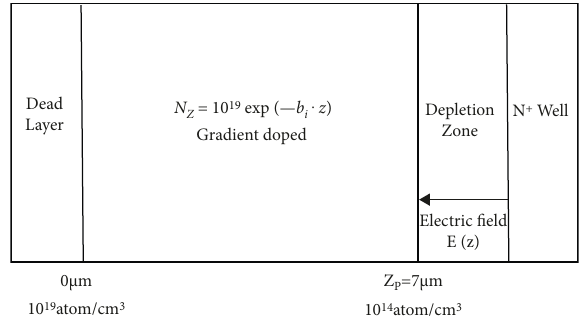
Figure 5: P -type silicon epitaxial layer overall index doping model.